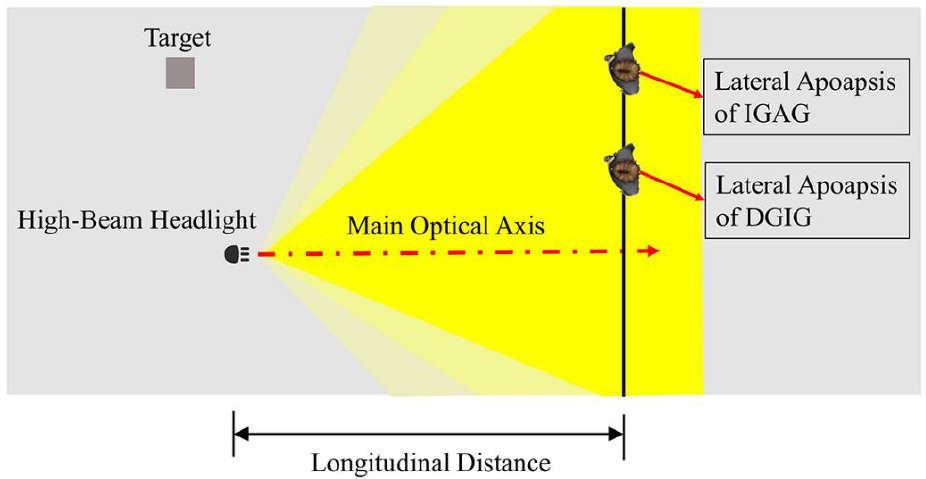
Figure 8. Diagram of lateral apoapsis (vertical distance = 0).